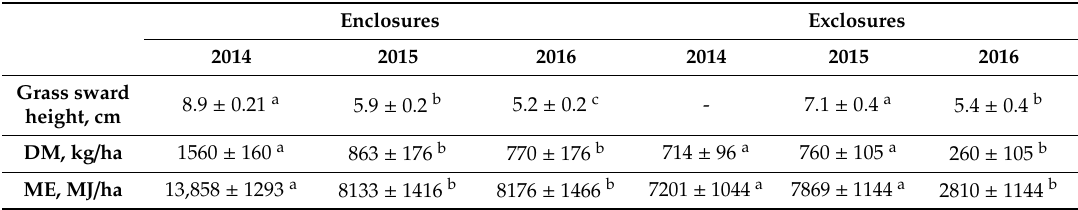
Table 4. Mean summer season grass sward height and content of dry matter (DM) and metabolizable energy (ME) per year in the enclosures grazed by horses and in the exclosures within each enclosure mown monthly from May 2014 to September 2016. Exclosures were mown at the same spots as sward height measurements were made.